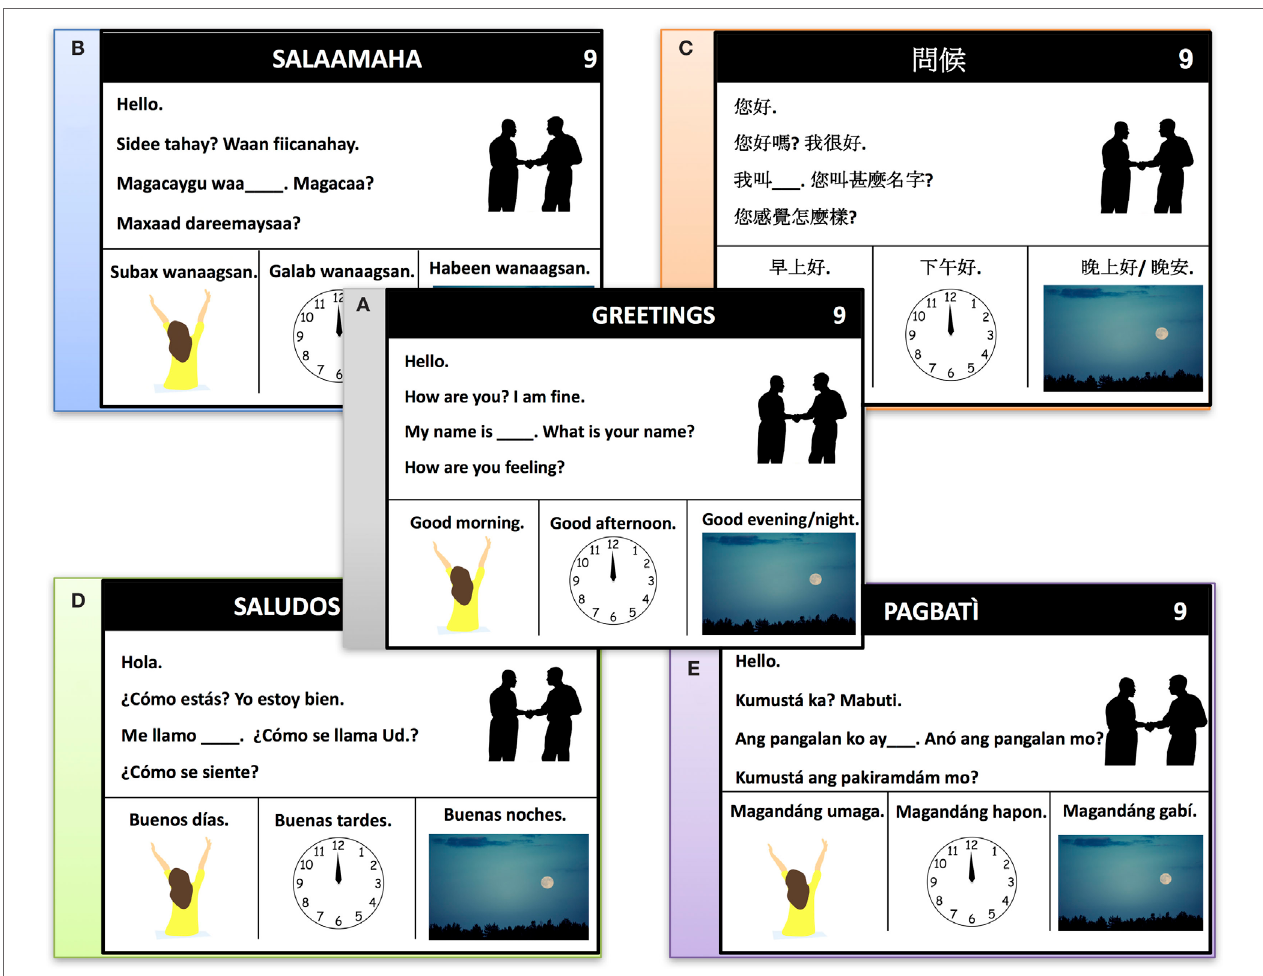
FigUre 1 | Sample page from the Specific-Purpose English Communication System for Seniors curriculum binder, including the English target page (a) together with translation pages in Somali (b) , Mandarin (c) , Spanish (D) , and Tagalog (e) . In the curriculum binders, the relevant translation page is printed on the flip side of the English target page, with binders available in English–Somali, English–Mandarin, English–Spanish, and